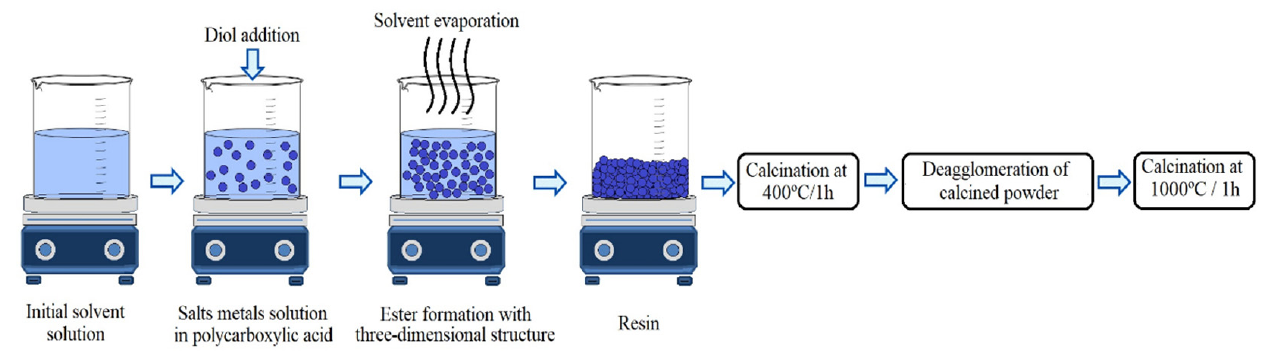
Figure 1. Synthesis representation.